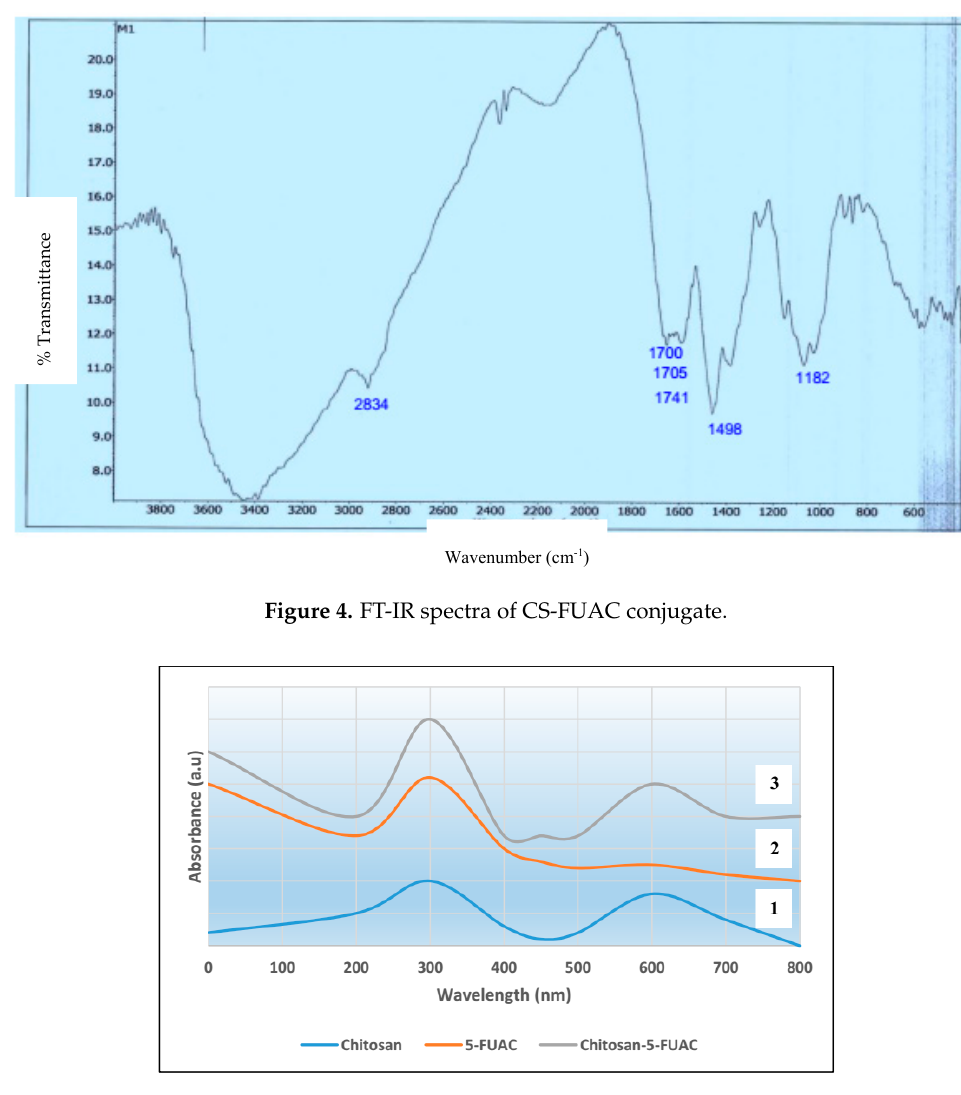
Figure 5. UV-vis spectra showing chitosan (CS) spectrum ‘1’, 1-acetic acid-5-fluorouracil (FUAC) spectrum ‘2’ and CS-FUAC conjugate spectrum ‘3’.